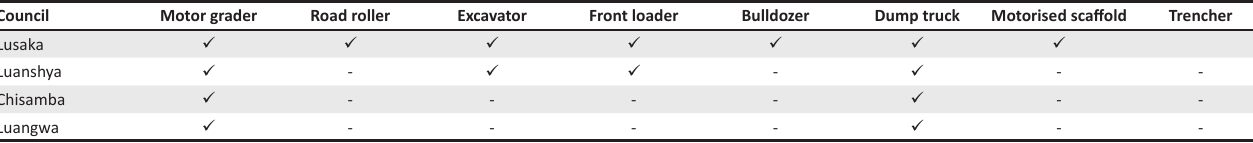
TABLE 4: Equipment for service provision.